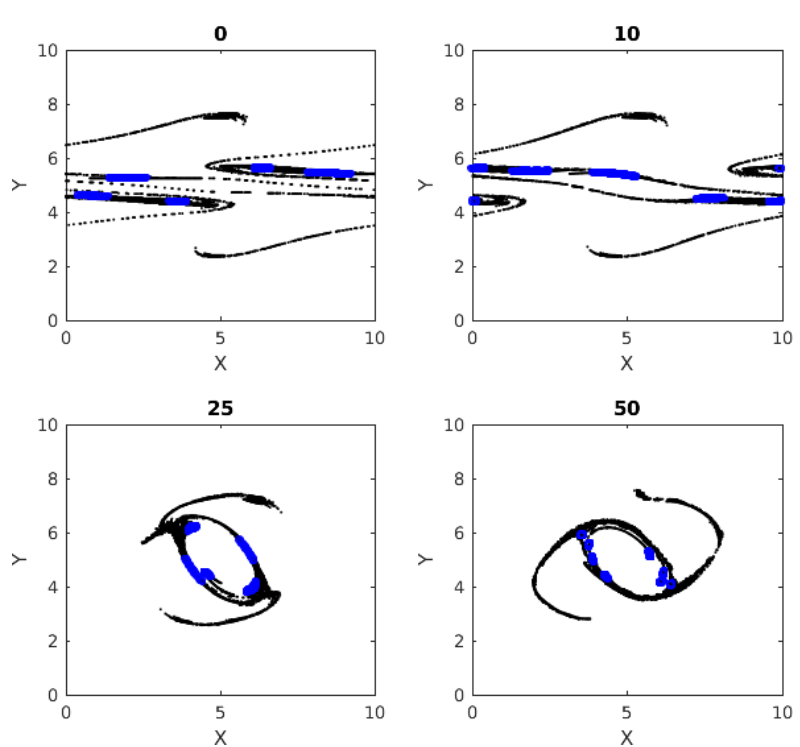
Figure 14. Dense clusters with (cid:15) = 40% and particles on rectangular grid with